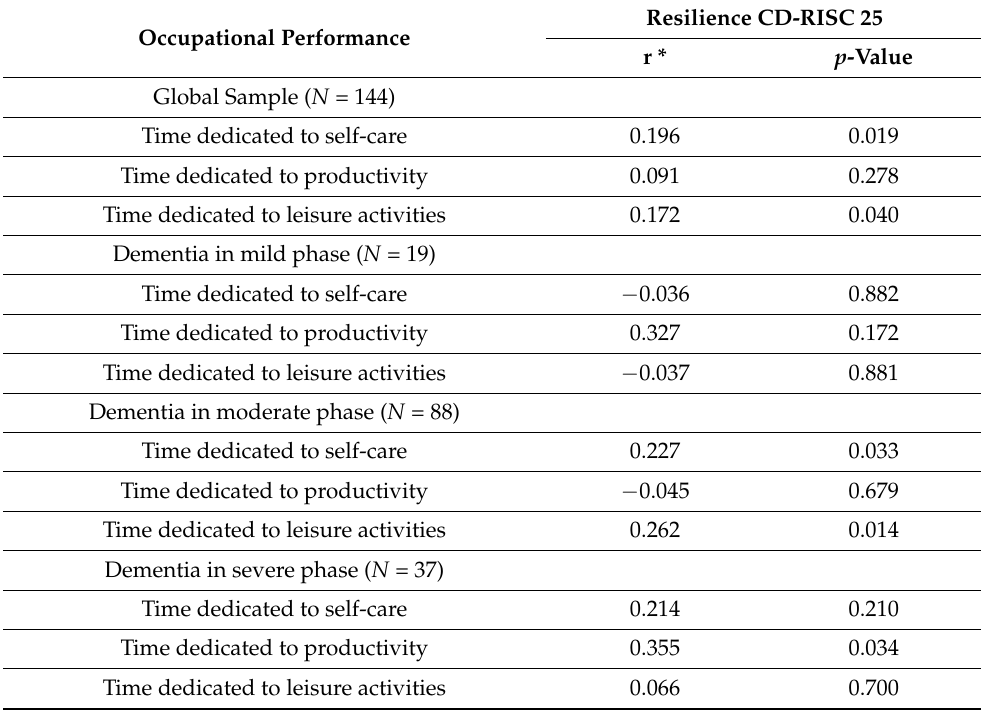
Table 4. Relationship between resilience and occupational performance in caregivers of patients with dementia. Global sample and differentiation according to the patient’s dementia